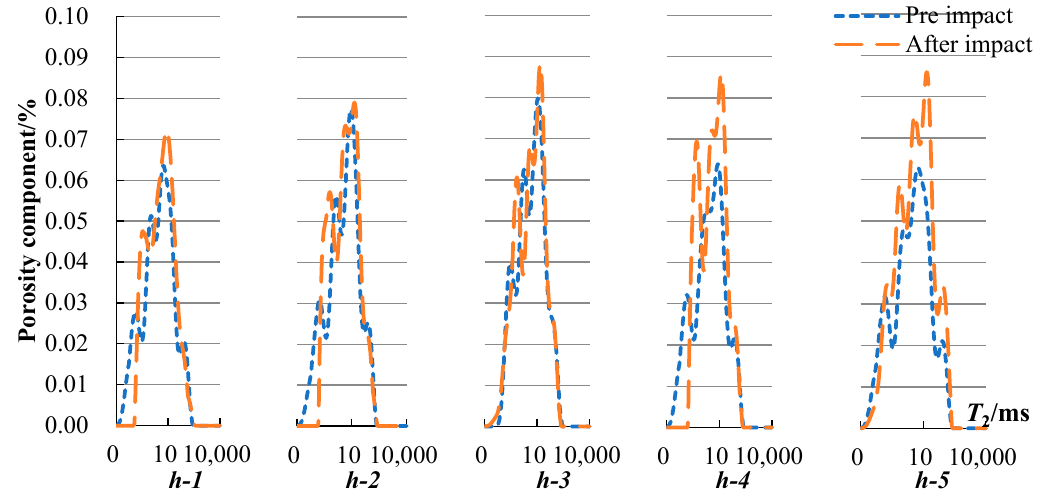
Figure 10. T 2 spectrum curves of half ‐ saturated samples.